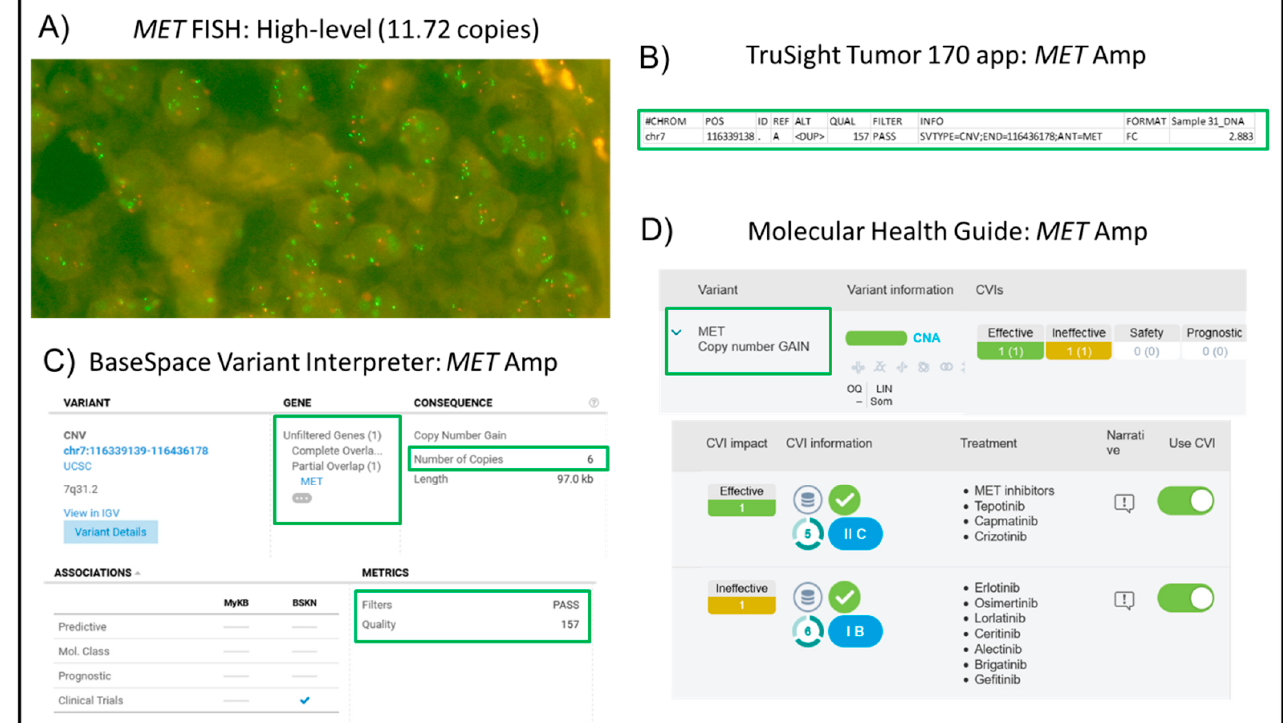
Figure 2. Sample 31 with a MET amplification determined by MET FISH ( A ), sequenced with the Table 170. app ( B ) on BaseSpace Sequence Hub and the BaseSpace Variant Interpreter ( C ) as well as the Molecular Health Guide Software ( D ). The amplification and the quality criteria are highlighted with a green rectangle for each software.